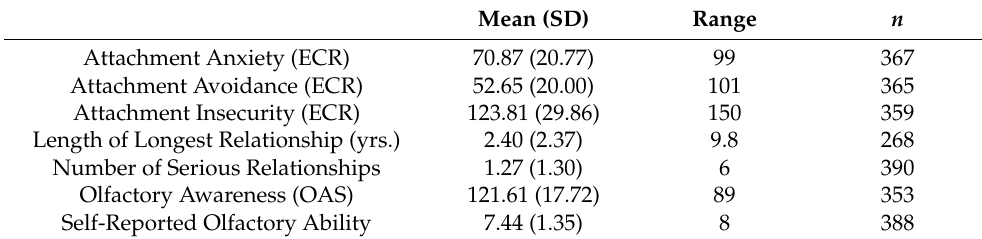
Table 1. Descriptive Statistics for Dependent